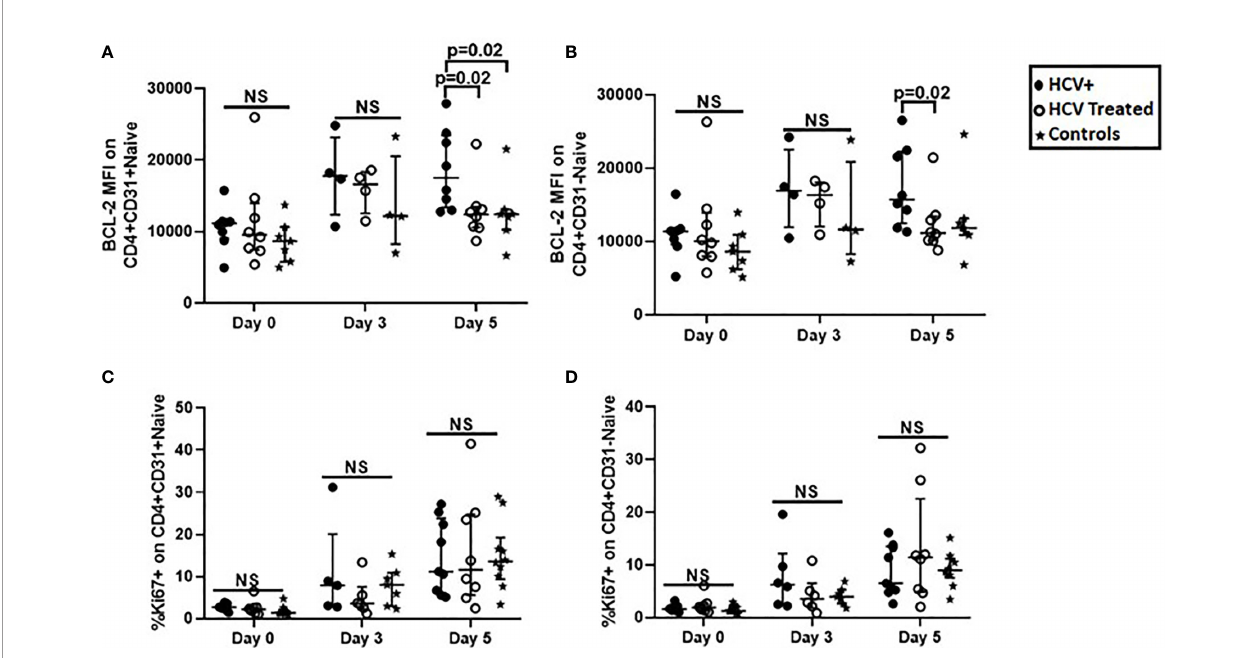
FIGURE 4 | BCL-2 expression after IL-7-stimulation was greater in CD31+ and CD31- naïve CD4+ T cell subsets from HCV infected persons compared to naïve CD4+ T cells from HCV DAA-treated persons and uninfected controls, while T cell Receptor-dependent cell cycle entry was similar in naïve CD4+ T cell subsets in all three groups. Magnetic bead puri fi ed (negative selection) naïve CD4 T cells from chronic HCV infected ( fi lled circles, n=8), HCV DAA-treated (open circles, n=8) and age-range matched uninfected control (stars, n=7) groups were stimulated with 10ng/ml of recombinant human IL-7 or 1ul anti-CD3/anti-CD28 Activator for 5 days. On 0, 3, and 5 days, fl ow cytometric analysis of BCL-2 following IL-7 stimulation (A, B) and Ki67 following anti-CD3/anti-CD28 stimulation (C, D) on naïve (CD27+CD45RA+) CD4+CD31+ and CD4+CD31- T cells was performed. Mann Whitney test was used for comparisons between two groups; p= <0.05 considered signi fi cant. NS represents non-signi fi cant p